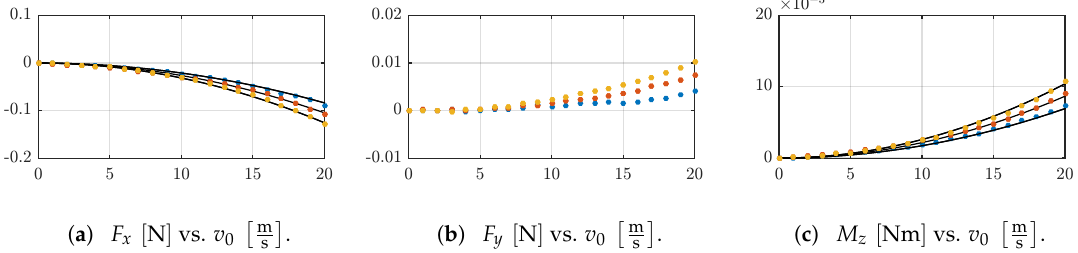
Figure 6. The experimental data sets for D4 (blue), D5 (red) and D6 (yellow) and the simulated data (black solid lines) are illustrated for the support reactions: ( a ) F x , ( b ) F y and ( c ) M z ; in dependence on the maximum velocity v 0